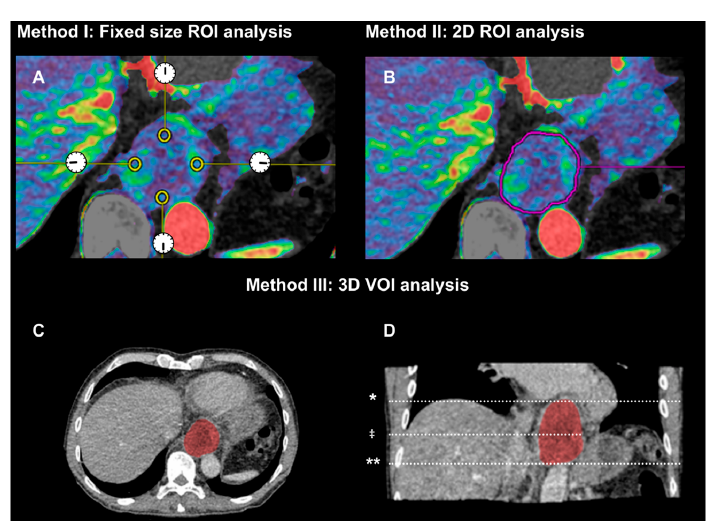
Figure 1. Illustration of three analysis methods. ( A ) method I includes four circular ROIs of fixed size (25–30 mm 2 ) at 12, 3, 6 and 9 o’clock in tumor periphery at the tumors center in the z ‐ axis; ( B ) method II is a 2D free ‐ hand ROI along tumor border in the center slice; ( C + D ) method III is a 3D volume of interest covering the entire tumor volume. ( C ) illustrates a single axial image and ( D ) illustrates the tumor volume in a reconstructed coronal plane. (*) marks tumor start level, (**) marks tumor end level, and ( ‡ ) marks tumor center level for methods I and II. The illustrated case had a tumor volume of 194 mL.